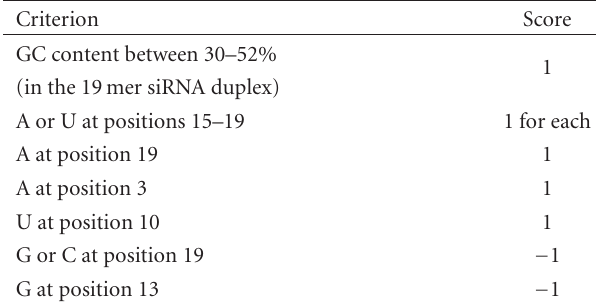
Table 1: Design criteria for siRNAs according to Reynolds et al